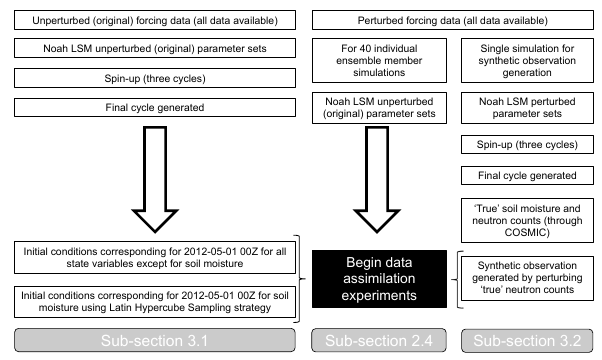
Figure 3. Experimental setup used in this study for data assimilation of synthetic observations of cosmic-ray